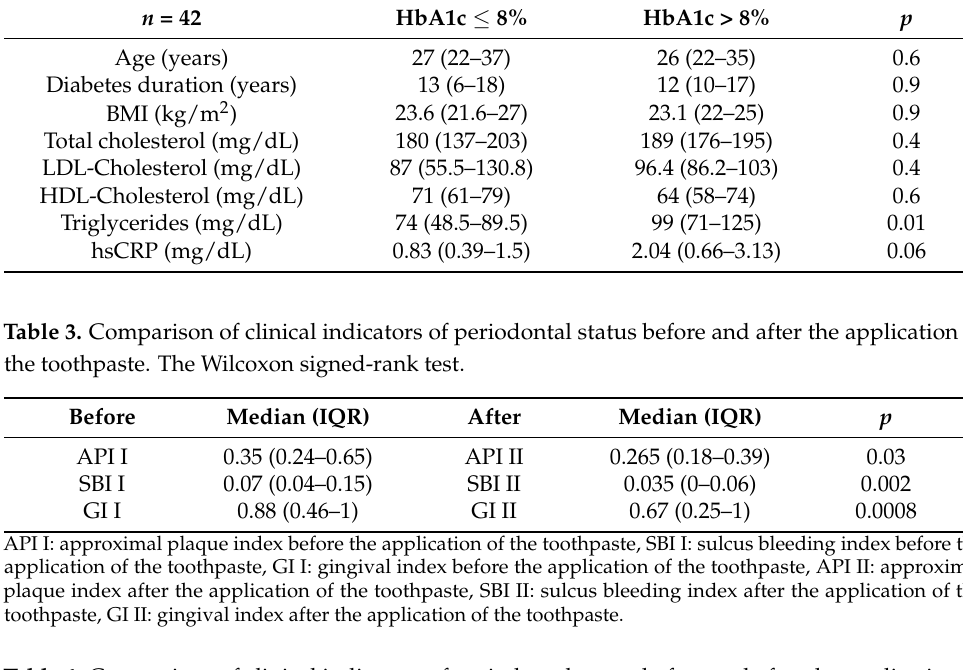
Table 4. Comparison of clinical indicators of periodontal status before and after the application of the toothpaste in the HbA1c ≤ 8% and HbA1c > 8% subgroups. The Wilcoxon signed-rank test.